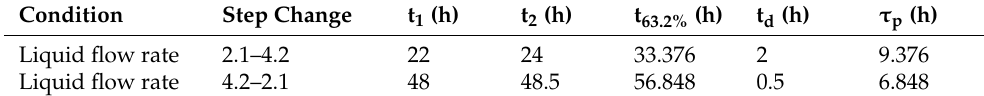
Table 5. Step-change in the liquid flow rate and HRT; dead time and time constant.